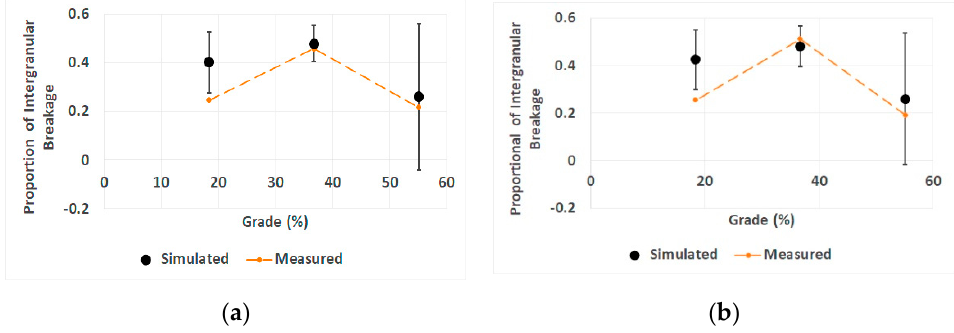
Figure 8. Dependency of contribution of intergranular breakage on the grade of the ore with plaster grains; ( a ) energy level of 117.2 (kJ), ( b ) energy level of 102 (kJ).